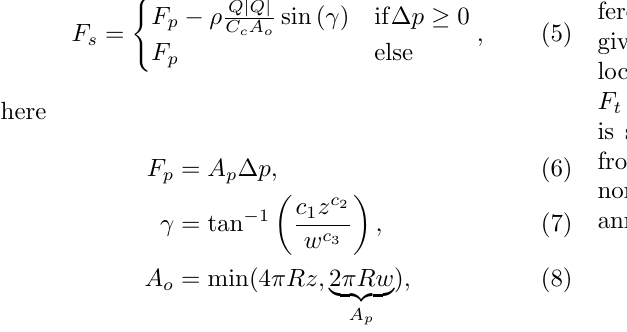
force magnitude. Normally the orifice equation is dif- ferentiated w.r.t time to get the flow gradient. This gives a damping term proportional to the moving